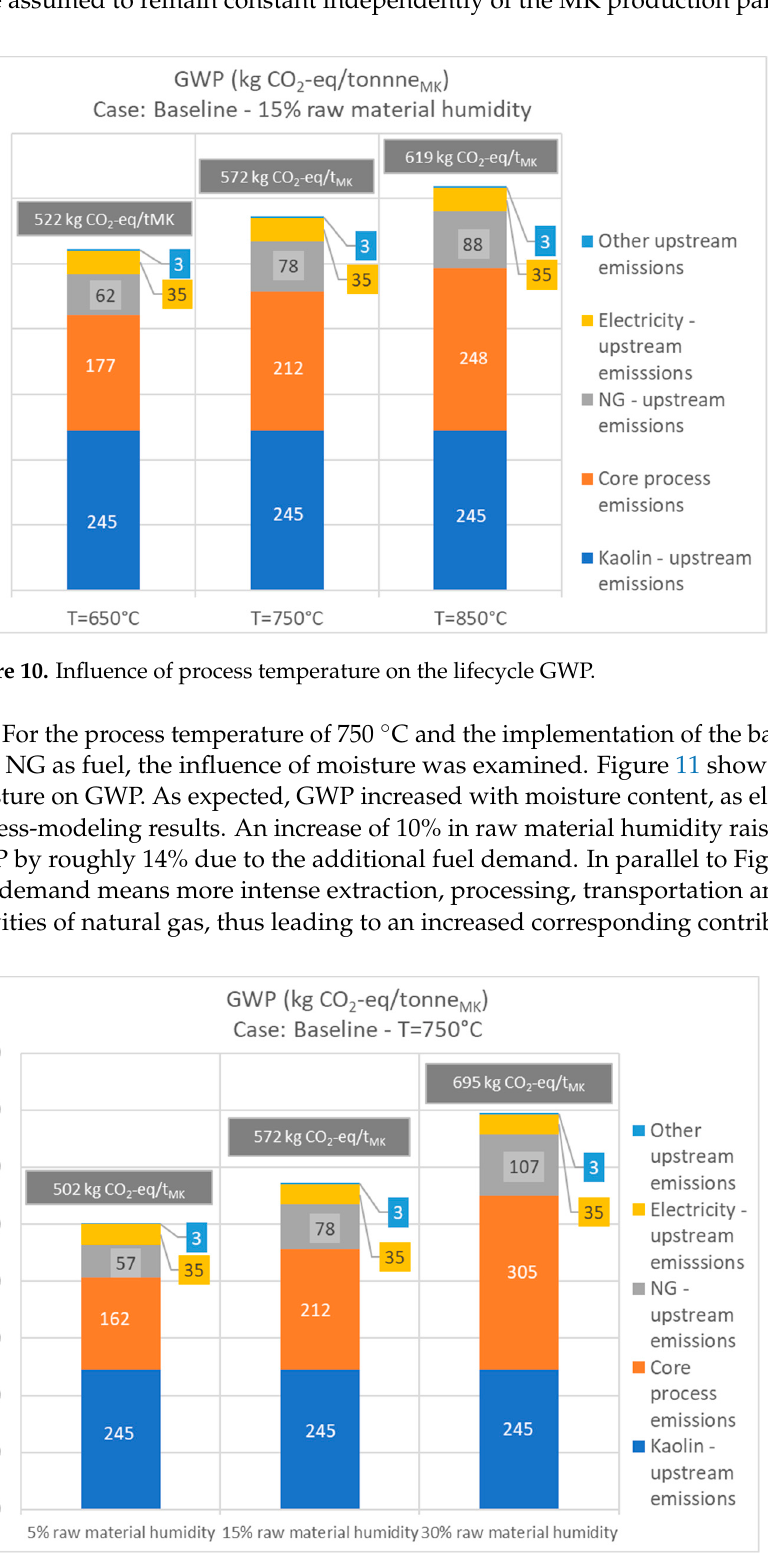
14 Figure 9. Calculated CO 2 emissions (kg/tonne MK ) by substituting coal (lignite) with alternative fuels. (C-EGR scenario/Reference Kiln Temperature: 750 °C/Reference moisture content: 15%wt). 3.2. LCA Results and Discussion